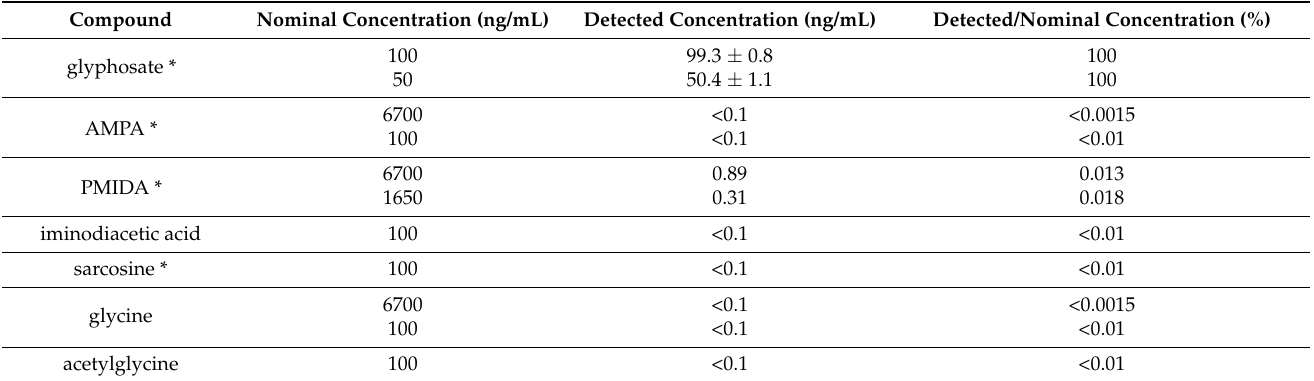
Table 3. Percentage of cross-reactivity (CR%) of the antiserum with glyphosate and structurally related